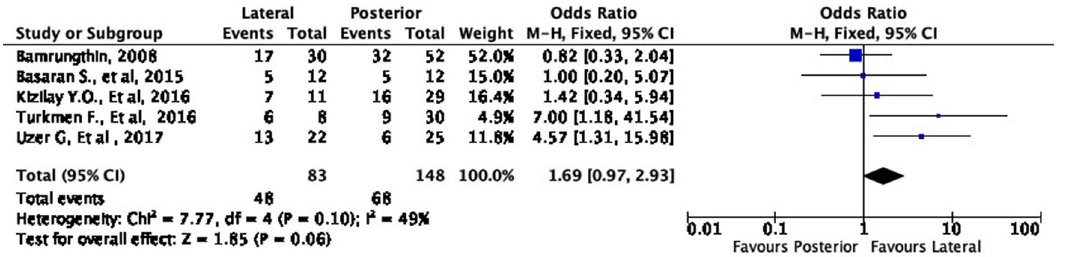
Figure 4. Comparison of functional outcome in the excellent subgroup.